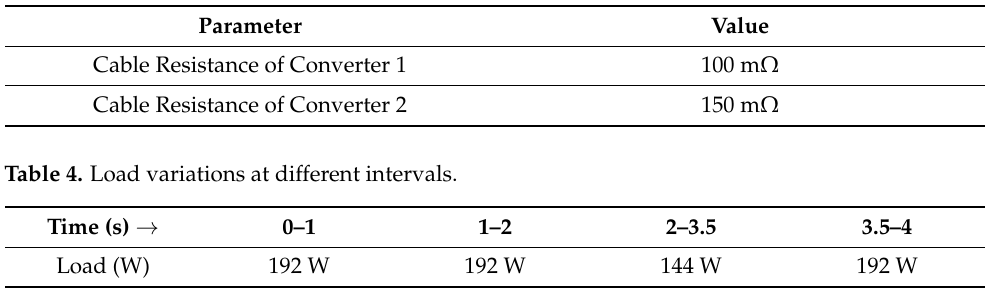
Table 3. Different cable resistances.